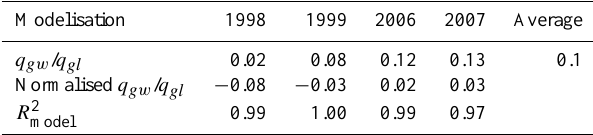
Table 4. Dilution model (Eq. 8) results for groundwater contribu- tions to Querococha discharge for the 1998, 1999, 2006 and 2007 dry seasons. q gw /q gl represents the ratio of groundwater and melt- water specific discharges. Normalized q gw /q gl is the q gw /q gl ra- tio minus the average q gw /q gl value from 1998, 1999, 2006 and 2007 dry seasons. R 2 is the coefficient of determination that model describes how the HBCM calculated relative contribution of end- members fits with the dilution